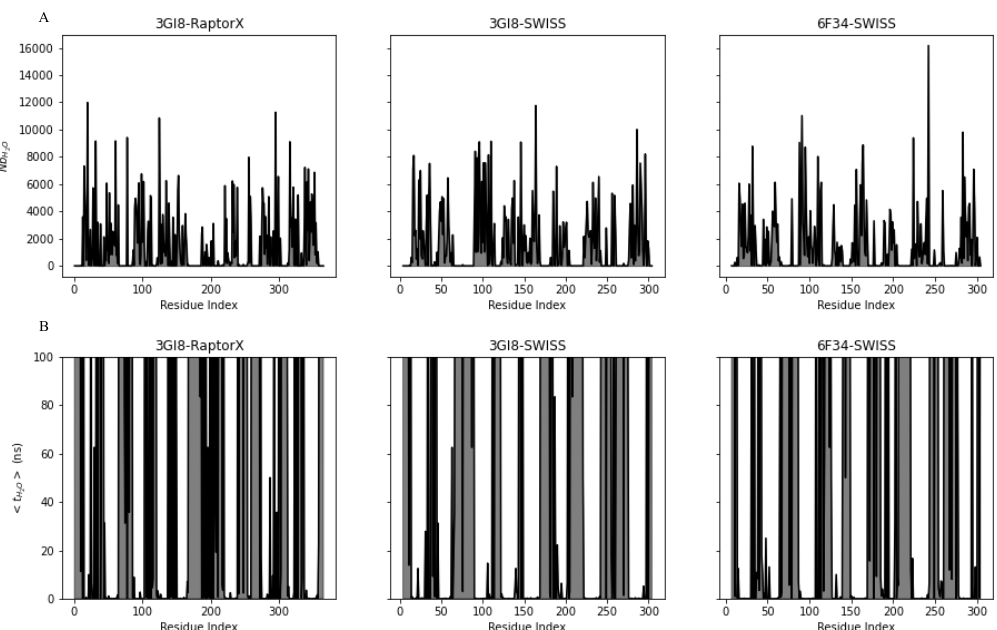
Figure 5. Number of binding events and average residence time for water to GerAB residues. In ( A ) the average number of binding events (Nb) are shown for residues in 3GI8-RaptorX, 3GI8-SWISS and 6F34-SWISS. ( B ) shows the average residence time of water to residues in 3GI8-RaptorX, 3GI8-SWISS and